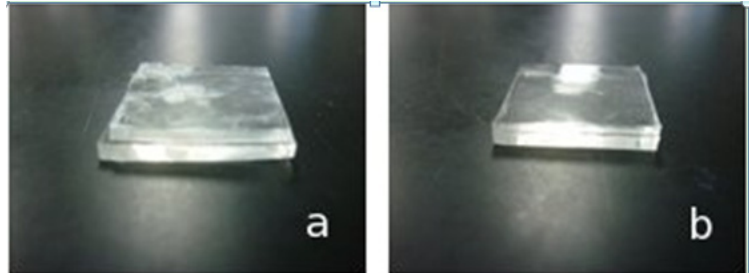
Figure 7. PDMS-PDMS samples of thickness ratio 1:1( a ) and 1:2( b ) were prepared by drenching the surfaces in concentrated sulfuric acid-based piranha solution for 45 s; ( c,d ) the samples were immersed in hexane for 10 min; ( e ) little distortion with no significant delamination in the sample, ( f ) drastic delamination leads to failure of the